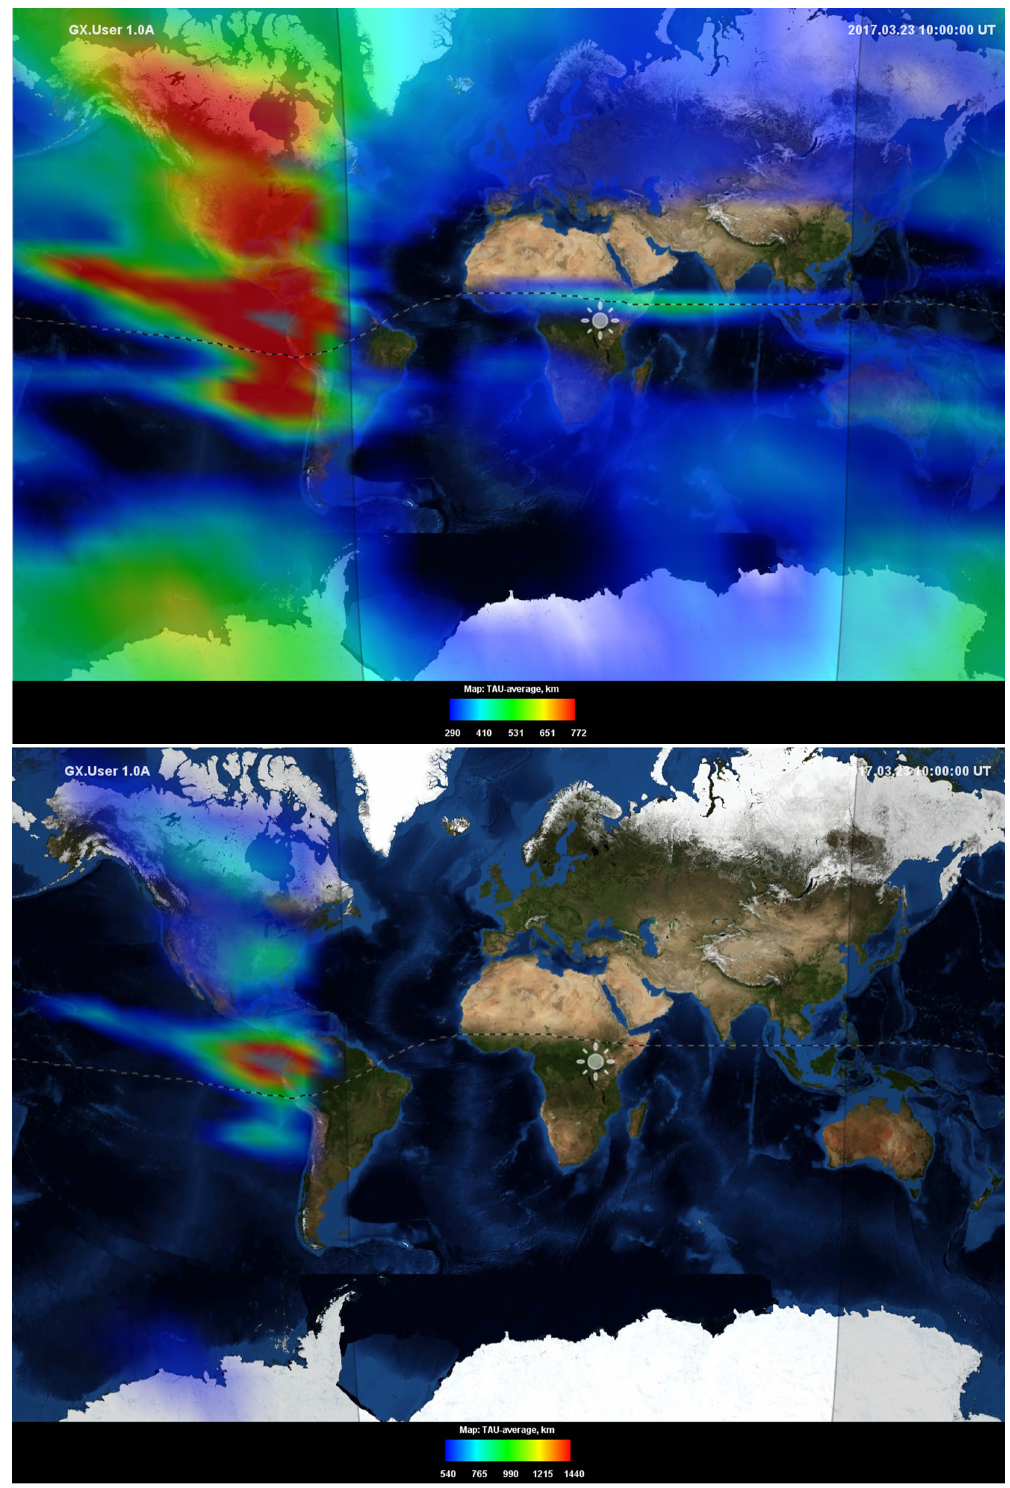
Figure 9. Climate slab thickness at 10 UT on 23 March 2017. Upper panel presents a typical view of ( τ ) with its increase just before dusk time. Bottom panel presents the same moment with adjusted scale to better depict the peak over Ecuador, with slab thickness exceeding 1500